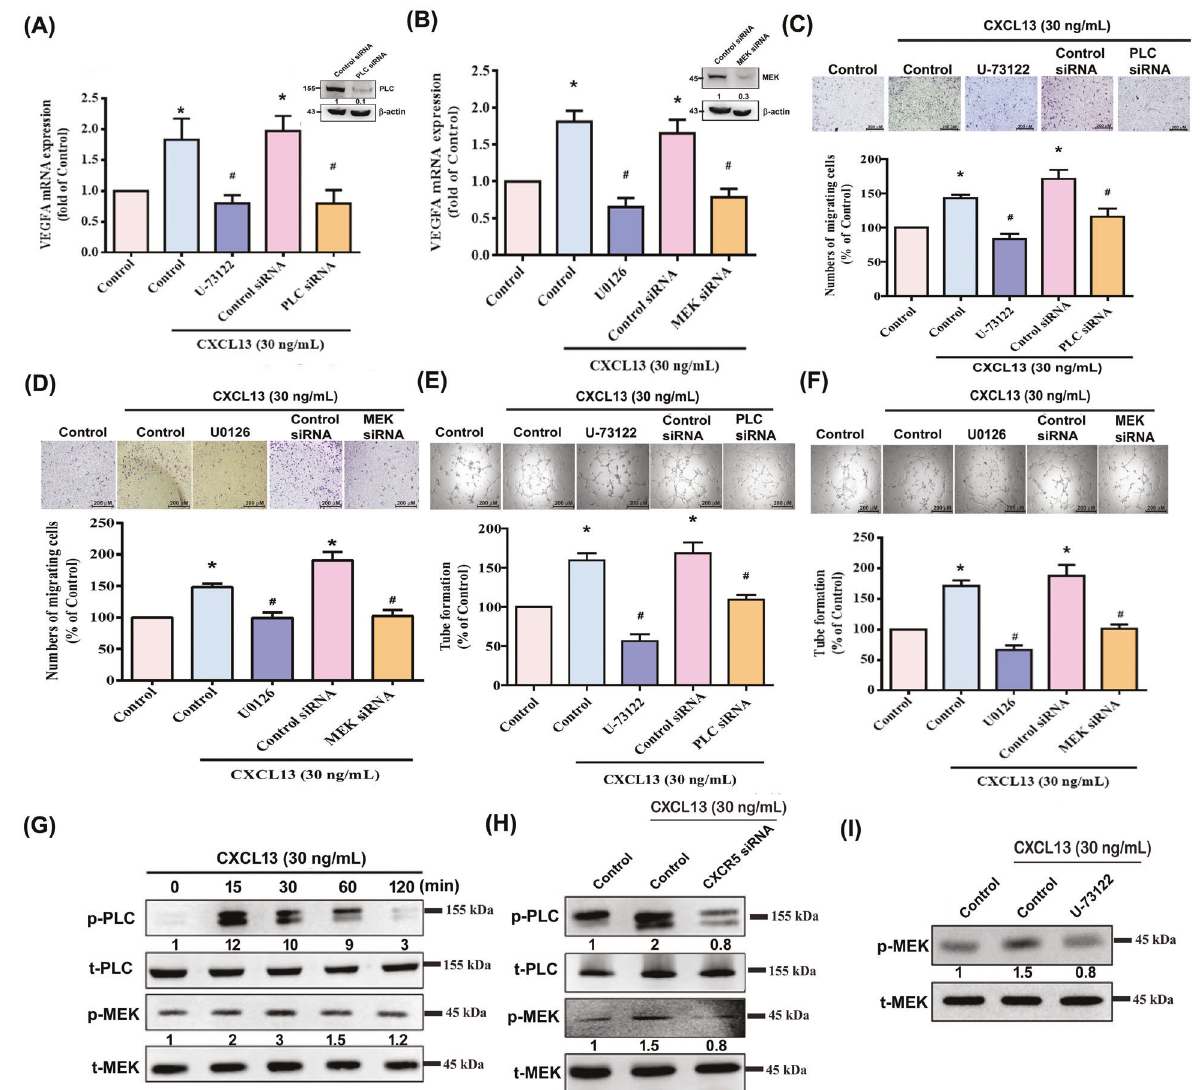
Fig. 5 PLC and MEK activation regulate CXCL13-induced VEGF expression and angiogenesis in EPCs. A – F EPCs were pretreated with PLC (U73122) or MEK (U0126) inhibitors or transfected with PLC and MEK siRNAs then stimulated with CXCL13. VEGF expression ( n = 6), cell migration ( n = 5), and tube formation ( n = 5) were measured. G After treating EPCs with CXCL13, PLC and MEK phosphorylation was examined by Western blot ( n = 4). H and I EPCs were pretreated with a PLC (U73122) inhibitor, or transfected with CXCR5 siRNA, then stimulated with CXCL13. PLC and MEK phosphorylation was examined by Western blot ( n = 4). * p < 0.05 versus the control group; # p < 0.05 versus the CXCL13- treated